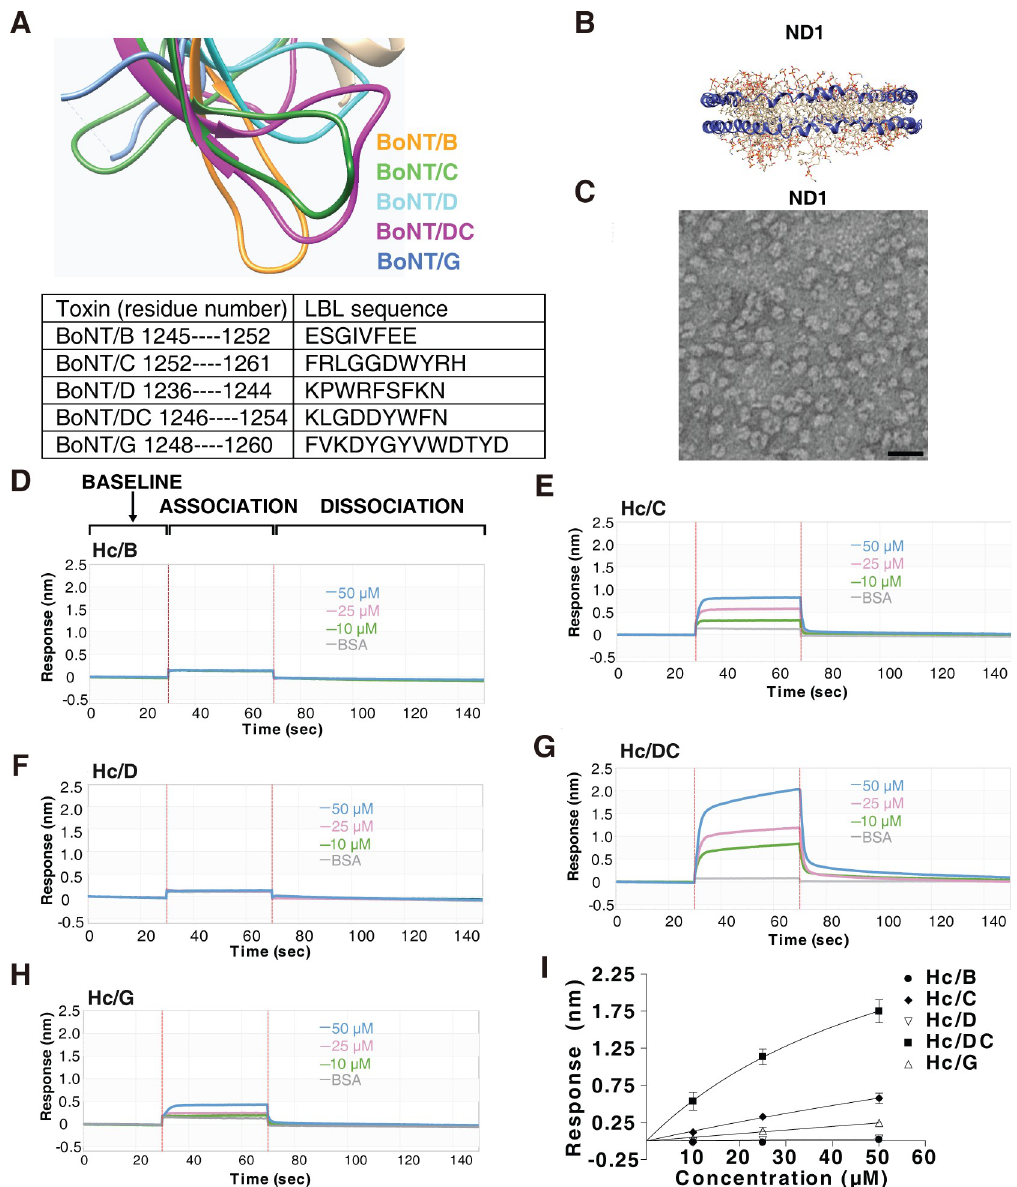
Fig 1. Characterizing binding of H C /B, /C, /D, /DC, and /G to lipid membranes in nanodiscs. (A) Structural overlay (top panel) and protein sequences (lower table) of the LBLs of H C /B, /C, /D, /DC, and /G. (B) Schematic drawing of nanodiscs (ND1). (C) The presence of nanodiscs was confirmed using negative staining EM. Scale bar represents 25 nm. (D–H). Binding of H C /B (panel D), H C /C (panel E), H C /D (panel F), H C /DC (panel G), and H C /G (panel H) to ND1 was examined using BLI assay. SA biosensors were exposed to three different concentrations of H C s (10, 25, and 50 μ M) for 40 seconds (association phase), followed by an 80-second washing step (dissociation phase). Representative sensorgrams were color-coded (green: 10 μ M; pink: 25 μ M; blue: 50 μ M) and shown, with the y-axis representing the shift in light wavelength upon binding (response nm). H C /B and H C /D did not show any detectable binding to ND1. H C /DC showed the strongest binding to ND1, and H C /C showed a modest level of binding, whereas H C /G showed low levels of binding. (I) The maximal binding signals of H C /B, /C, /D, /DC, and /G to ND1 as described in panels D–H were averaged and plotted (mean ± SD, n = 3). H C /DC showed the highest binding to ND1 among all H C s. Numerical values for (I) are available in S1 Data. BLI, biolayer interferometry; BSA, bovine serum albumin; EM, electron microscopy; H C , C-terminal receptor-binding domain; LBL, lipid-binding loop; ND1, receptor-free nanodisc; SA, streptavidin.